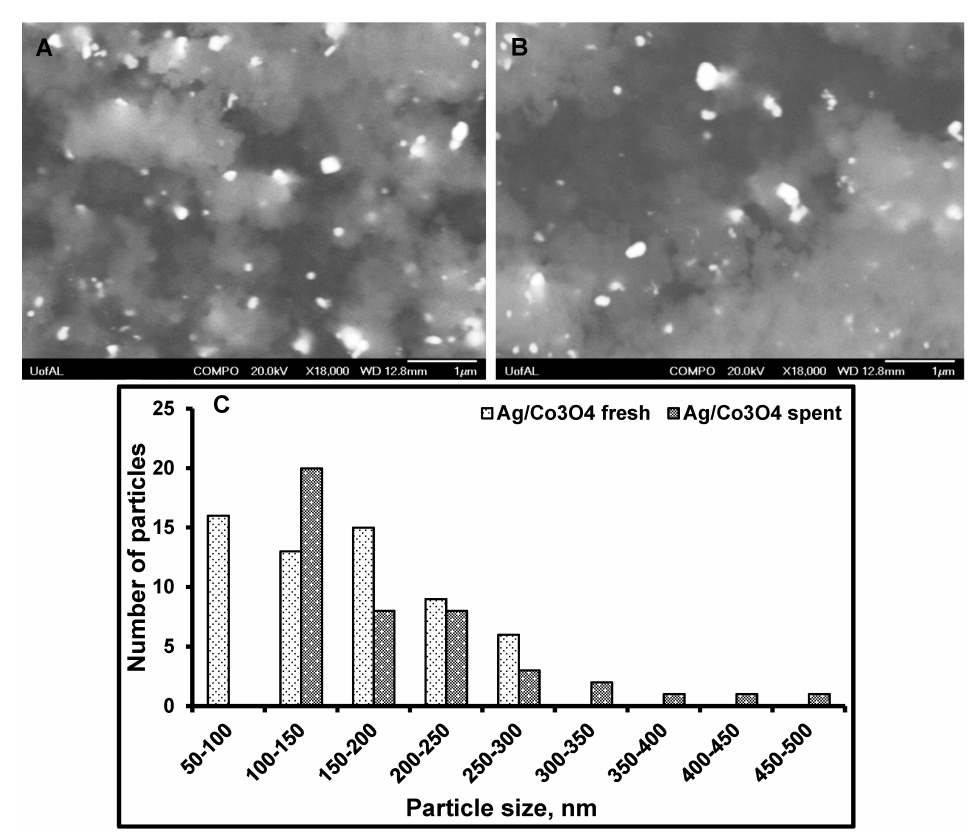
Figure 12. Washing studies of Ag/Co 3 O 4 in hexane: ( A ) SEM of fresh Ag/Co 3 O 4 ; ( B ) SEM of spent Ag/Co 3 O 4 ; ( C ) particle size distribution of fresh and spent Ag/Co 3 O 4